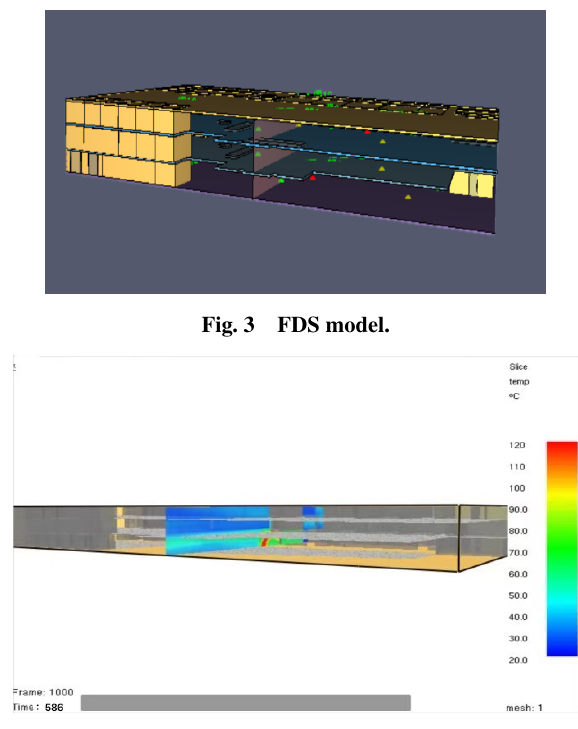
Fig. 4 Temperature distribution at 586